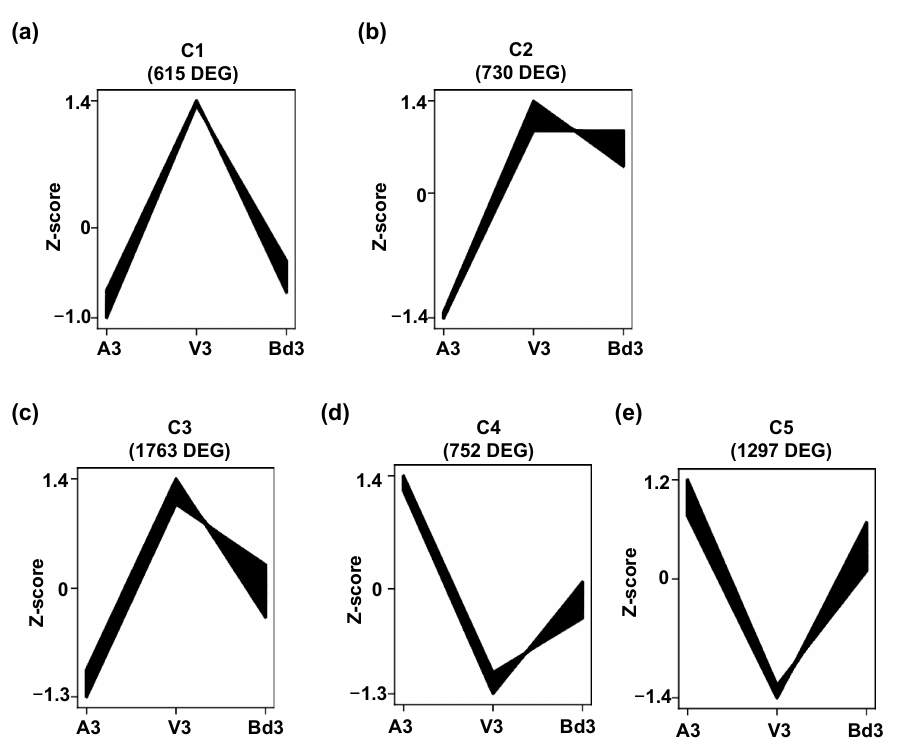
Figure 4. Cluster profiles of differentially expressed genes (DEG). Based on the transcript abundance and expression trends, the DEG identified from avirulent (A3), virulent (V3), and Bd3 larvae 3 days after hatch (DAH) were clustered into five groups. ( a ) C1 cluster with 615 DEG; ( b ) C2 cluster with 730 DEG; ( c ) C3 cluster with 1763 DEG; ( d ) C4 cluster with 752 DEG; ( e ) C5 cluster with 1297 DEG.